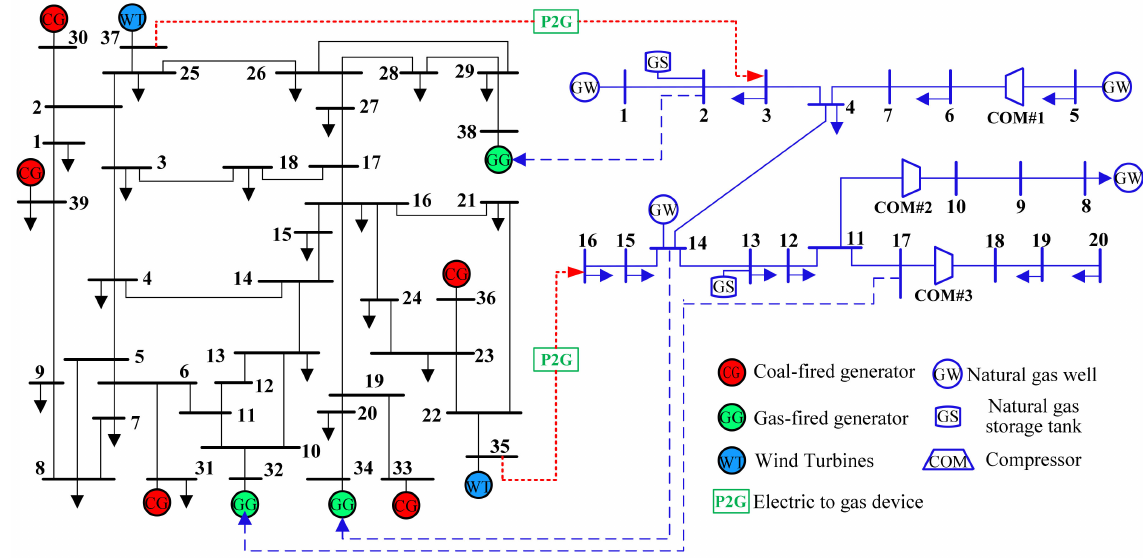
Figure 6. The structure diagram of the simulation example of